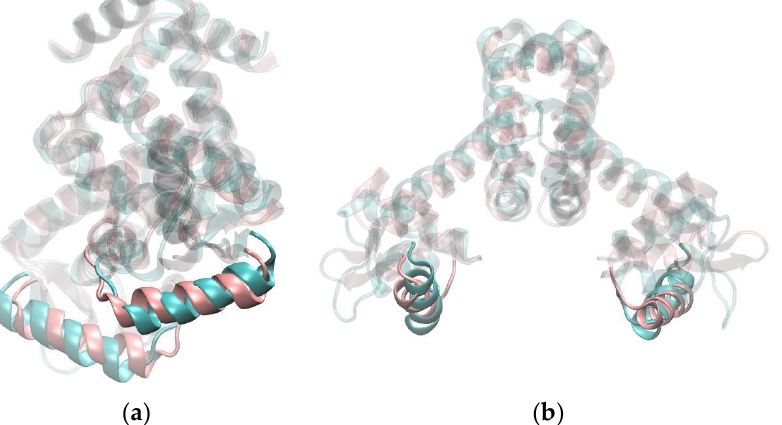
Figure 3. Superposition of the centroids of the most-populated clusters of MD trajectories of apo– and Mn 2+ –MntR systems. The apo system is shown in blue, while the Mn 2+ system is shown in pink. Two different orientations of the protein ( a , b ) are shown.